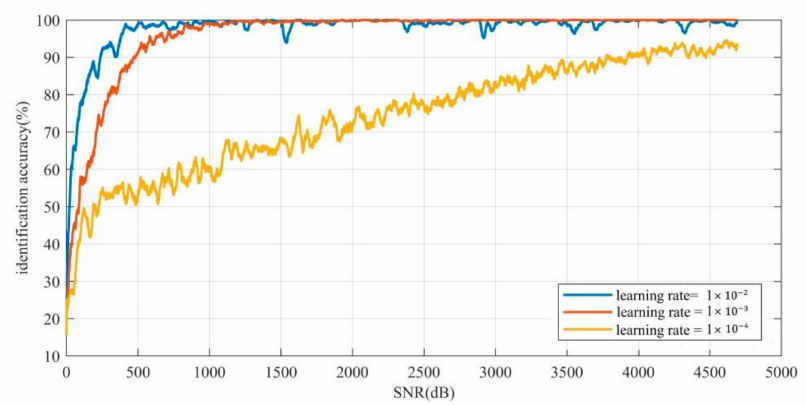
Figure 5. Identification accuracy curves under different learning rates vs.